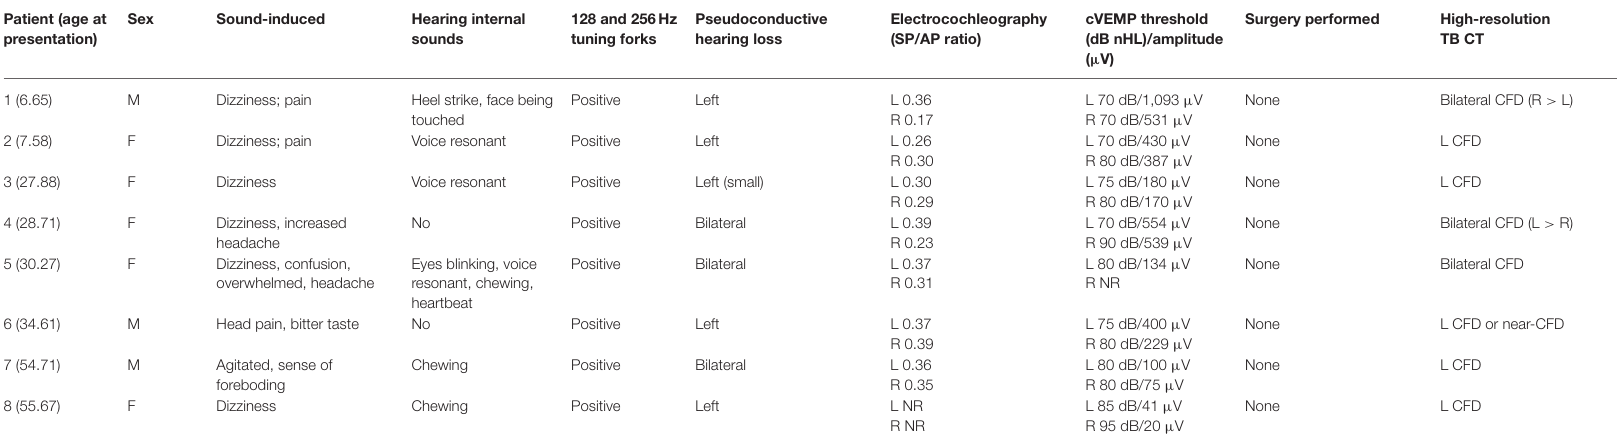
level; Dizziness, gravitational receptor asymmetry type of vertigo (e.g., as if on a boat, rocky, wavy, tilting, being pushed, pulled, flipped, or sense of floor falling out from under them); ELH, endolymphatic hydrops (abnormal summating potential/action potential [SP/AP] ratio > 0.42 by electrocochleography); F, female; HA, headache; L, left; M, male; TB, temporal bone; R, right. The classification of headache and migraine used in this study followed the International Headache Society’s International Classification of Headache Disorders, 3rd edition